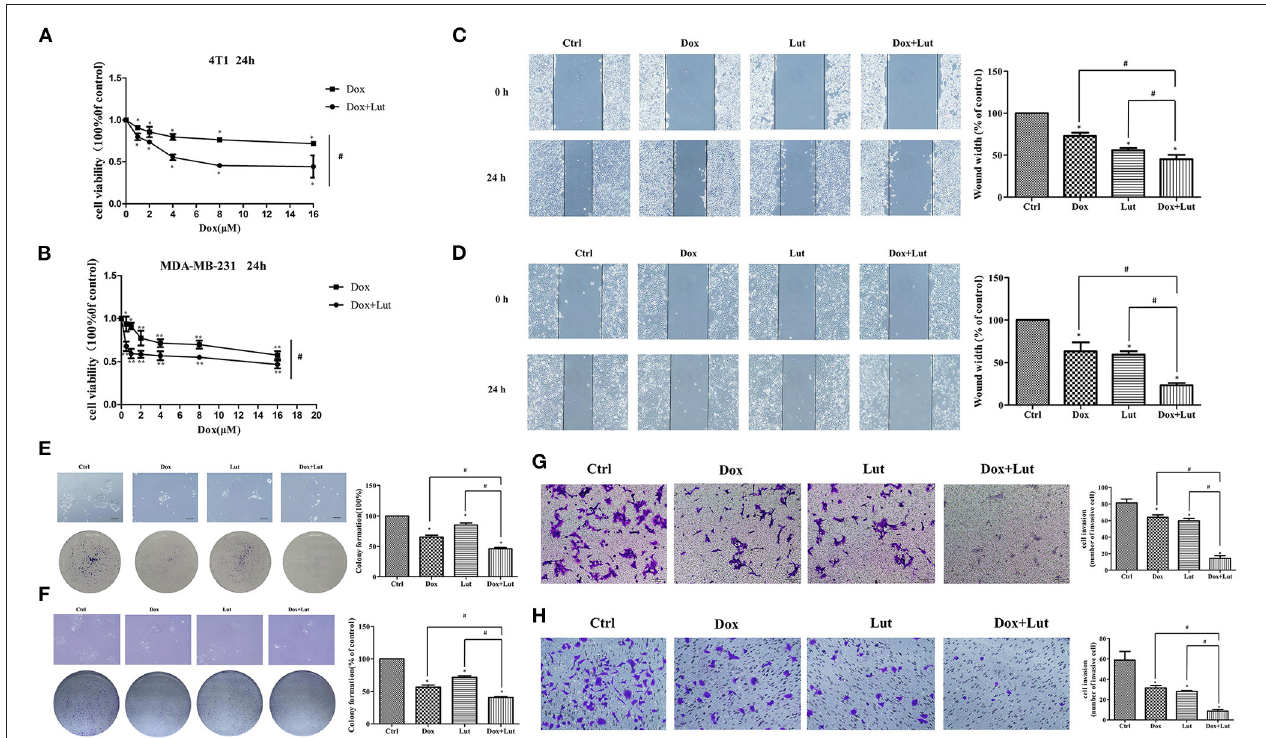
FIGURE 8 | Lut promotes the antitumor effect of Dox in 4T1 and MDA-MB-231 cells. (A) 4T1 and (B) MDA-MB-231 cells were treated with Dox or Dox added with Lut (40 µ M) at concentrations of 0, 1, 2, 4, 8, or 16 µ M for 24h. MTT assays were performed, and cell viability was determined. Photographs and quantification of wounds, colony formation, and cell migration to (C,E,G) 4T1 and (D,F,H) MDA-MB-231 cells treated with Dox (2 µ M) or Dox added with Lut (40 µ M). Mean ± SD, n = 3 independent experiment. * P < 0.05 compared with control group. # P < 0.05 compared with Dox